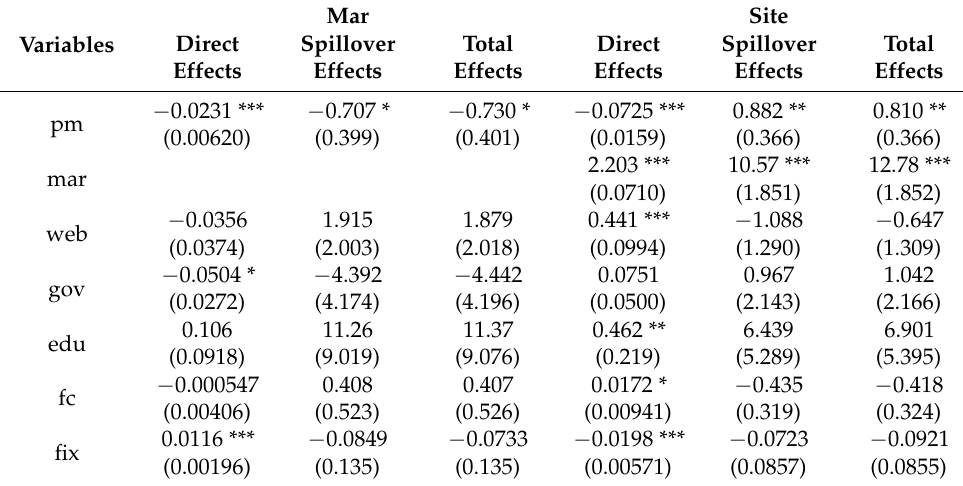
Table 12. Mechanism analysis with market scale